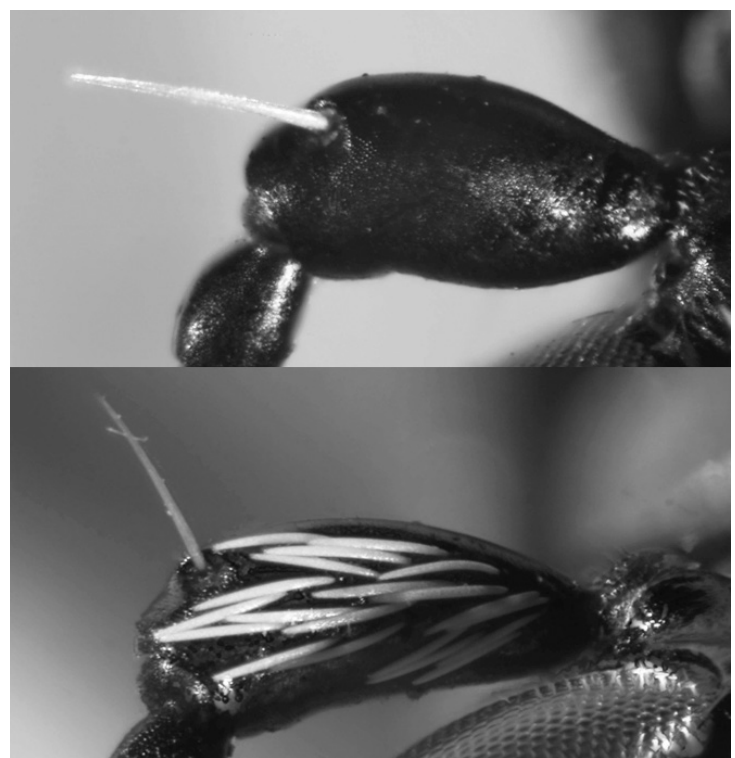
Figure 54. 1 st antennal segment: with only one erect distal seta ( Calomera alboguttata ; above) and with one erect distal seta and additional recumbent white setae ( Lophyra histrio ;